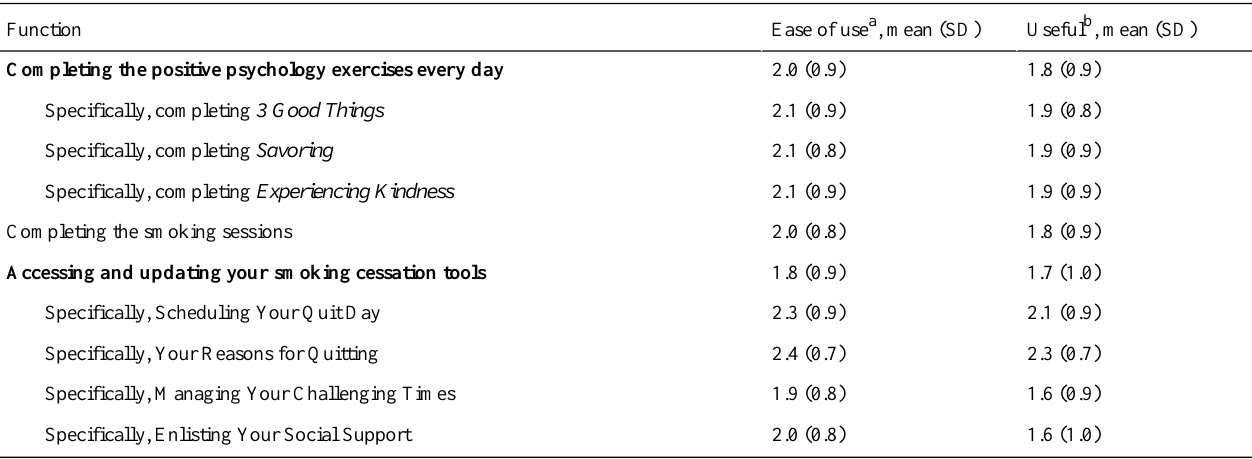
Table 2. Ratings of the Smiling Instead of Smoking